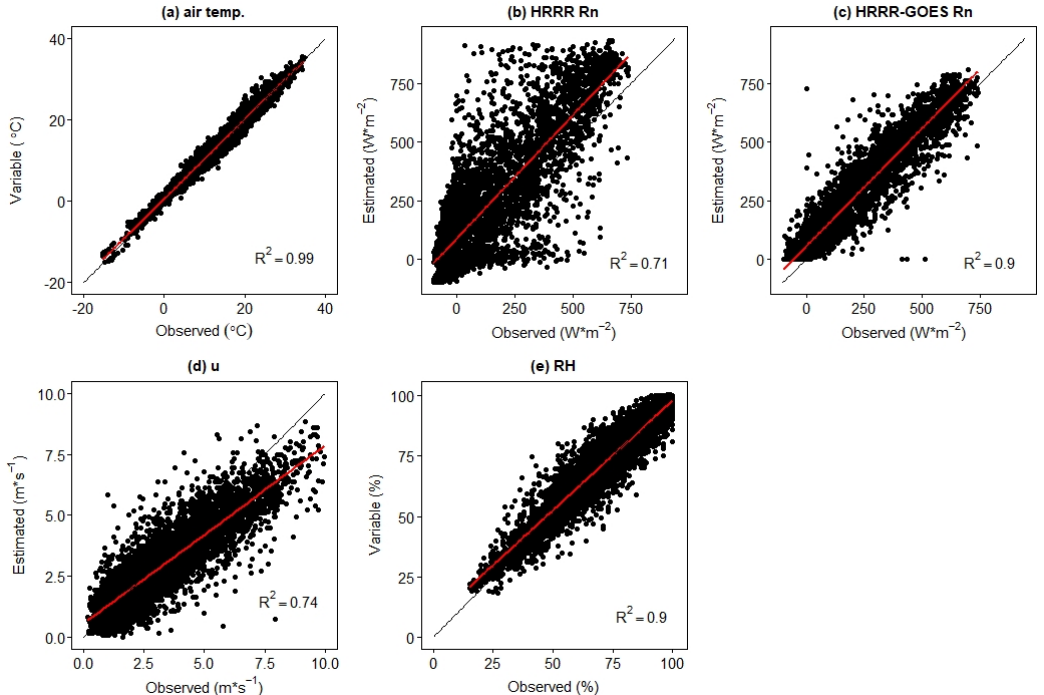
Figure 3. Scatter plots of selected observed hourly input data vs. extraction of hourly numerical weather prediction (NWP) outputs as modeled input data for Tower 11. A black solid line indicates 1:1 line and a blue solid line represents a linear regression line.